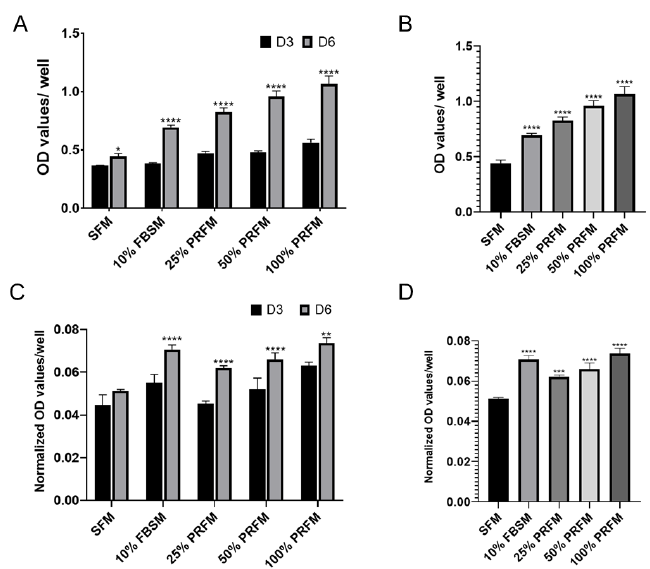
Figure 1. Effects of platelet-rich fibrin conditioned medium (PRFM) on cell viability and accumulated glycosaminoglycan (GAG) content. ( A ) The stimulatory effects of DMEM/F-12 containing 10% fetal bovine serum medium (FBSM), and 25%, 50%, and 100% PRFM on cultured porcine chondrocytes were compared with serum-free medium (SFM) for 6 days. ( B ) On day 6, the cell number significantly increased after FBS and PRF stimulation, in a dose-dependent manner. ( C ) The accumulated GAG content was significantly higher in the groups of cells treated with 10% FBSM, as well as 25%, 50%, and 100% PRFM. ( D ) Chondrocytes treated with FBSM and 25%, 50%, and 100% PRFM for 6 days exhibited significantly higher levels of accumulated GAG content as compared with the control SFM group. Values are presented as mean ± SD. D3, day 3; D6, day 6; and OD, optical density. * p < 0.05, ** p < 0.01, *** p < 0.001, and **** p < 0.0001. Int. J. Mol. Sci. 2020 , 21 , x FOR PEER REVIEW